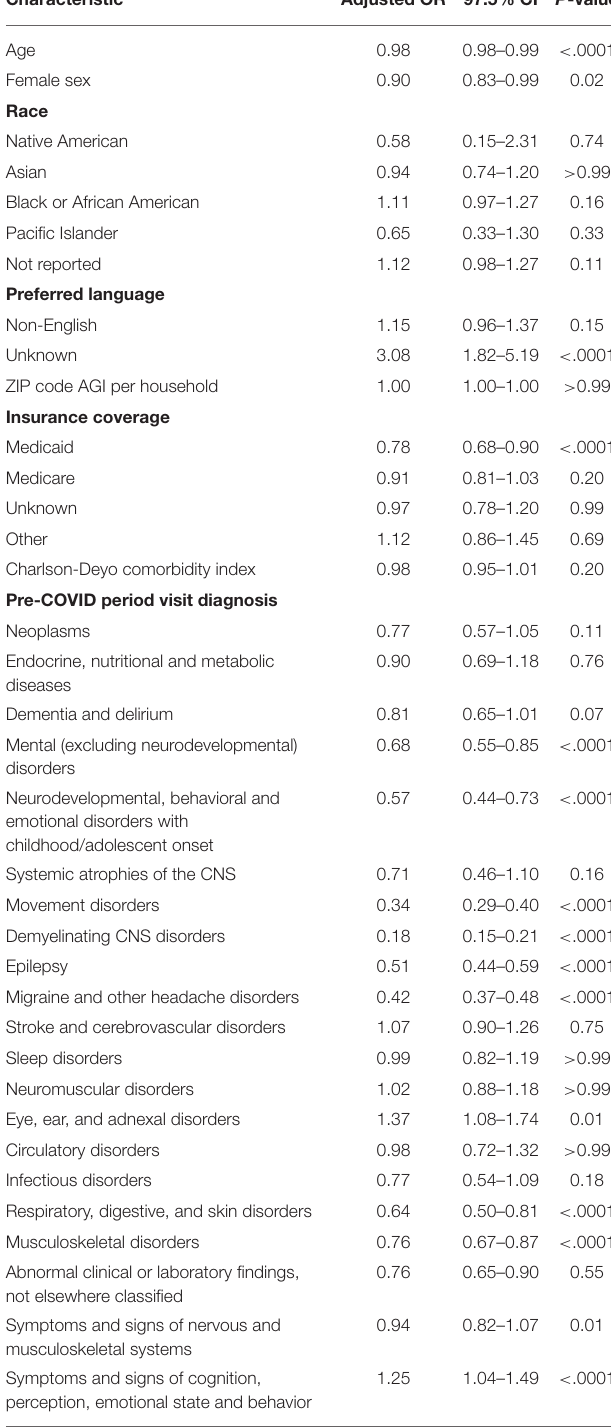
TABLE 4 | Patient characteristics, stratified by loss to follow-up during the COVID period. Characteristic Lost to follow-up